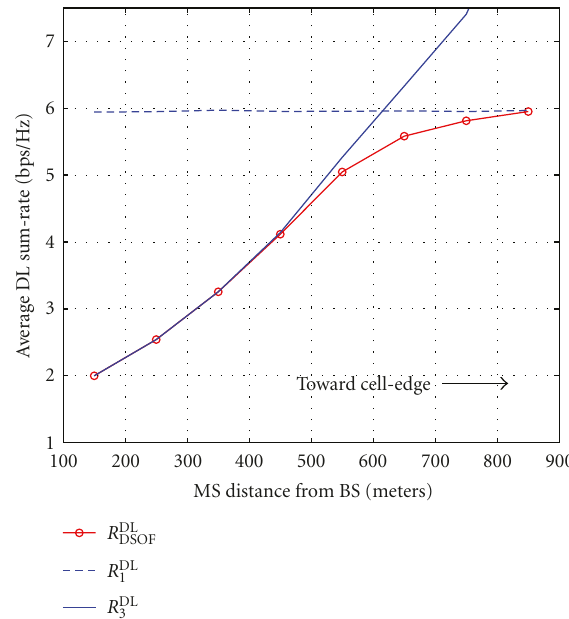
Figure 6: Performance break down of phases I and III for proposed two-way DSOF where R DL